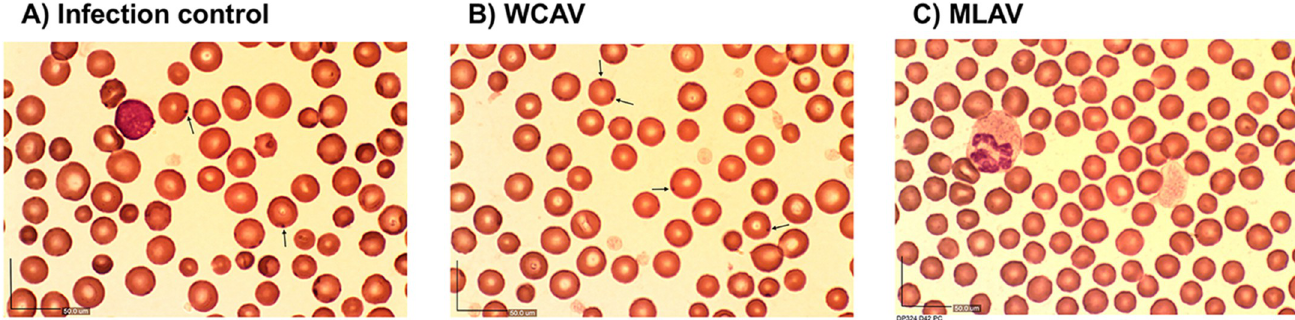
Fig 4. Thin blood smears assessed by light microscopy. Blood smear images were presented from one animal each for day 42 post infection challenge from all three experimental group animals. The images were collected following viewing with a 40x magnification. A . marginale inclusions are shown by black arrows (observed only in infection controls and WCAV animals; panels A and B), but not in MLAV animals (C). The A . marginale inclusions (identified with arrowhead lines) and anisocytosis are evident in both non-vaccinated infection controls WCAV vaccinees, but not in MLAV vaccinees. The length bars on the bottom left corner of each panel represent 50 microns.